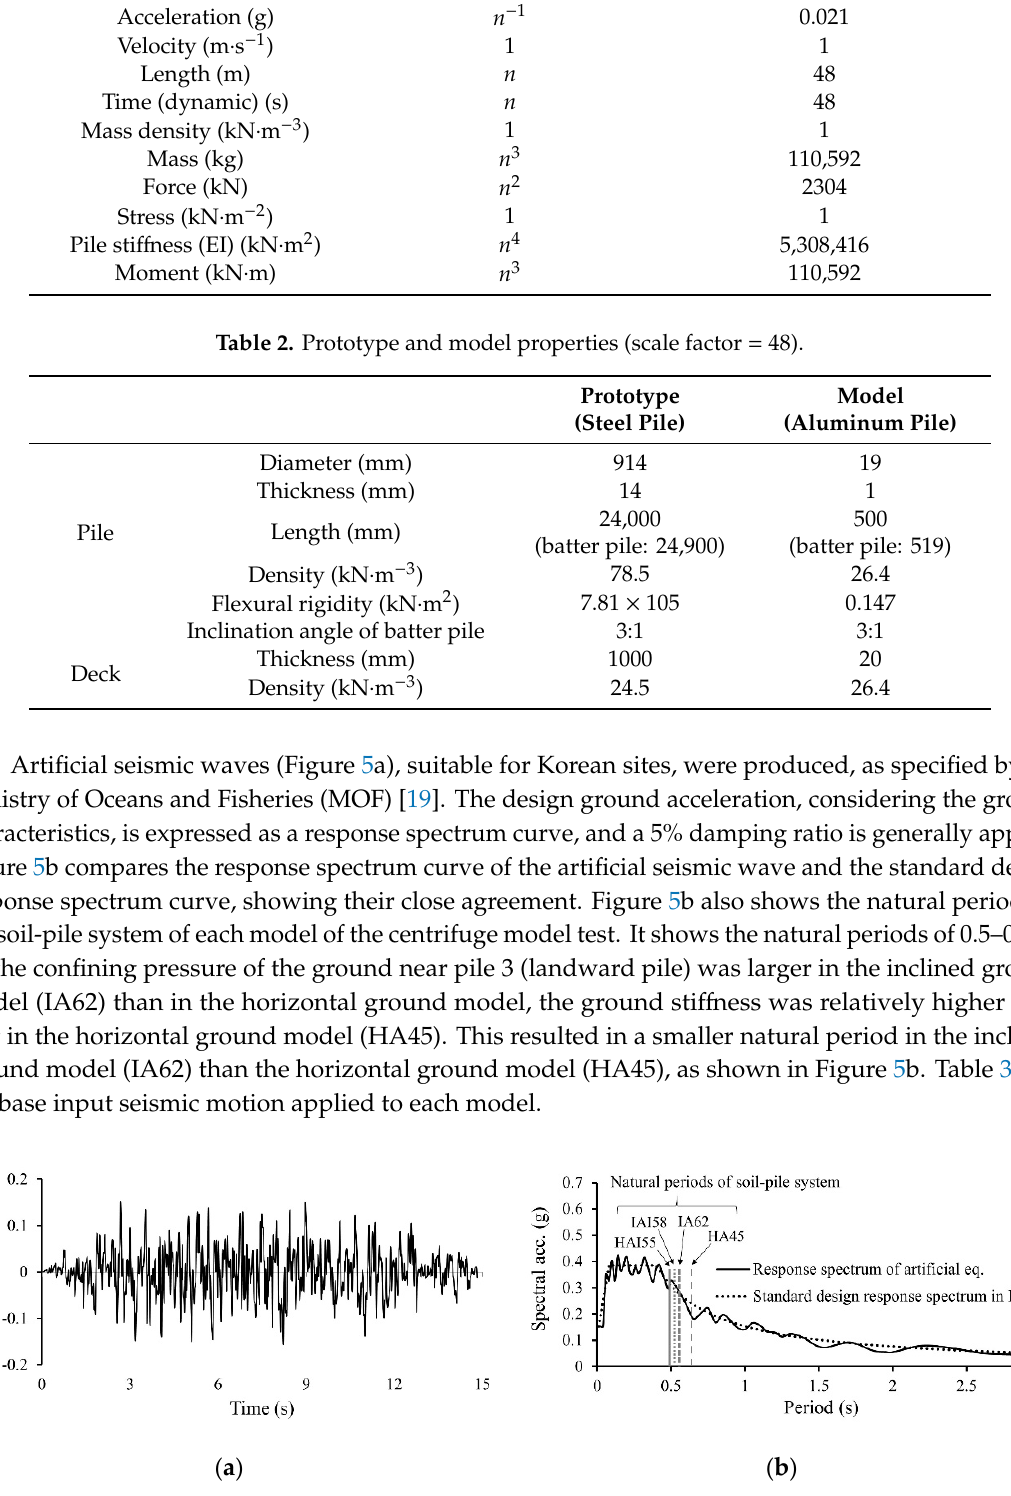
Table 1. Model scaling factors and values.